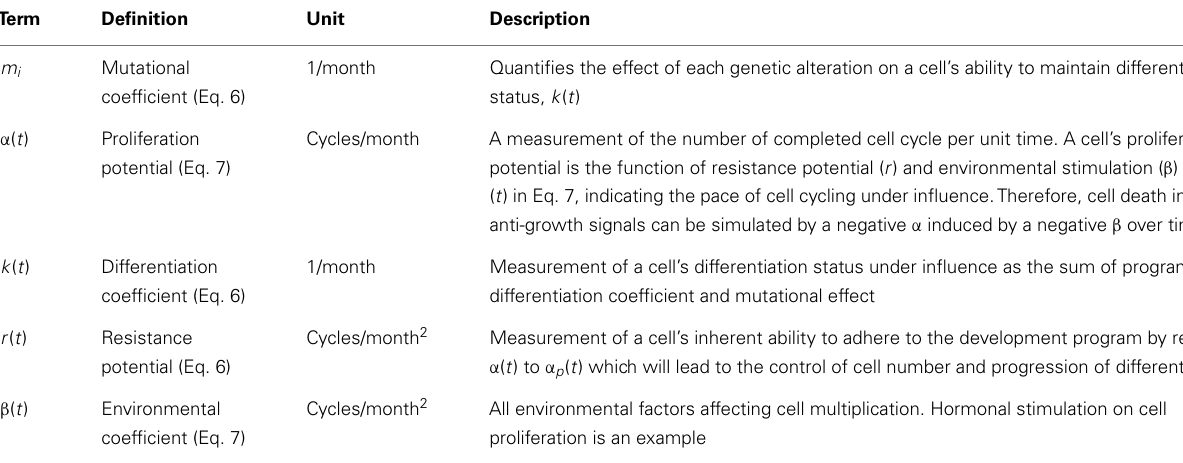
Table 2 |Terms for the growth of a single